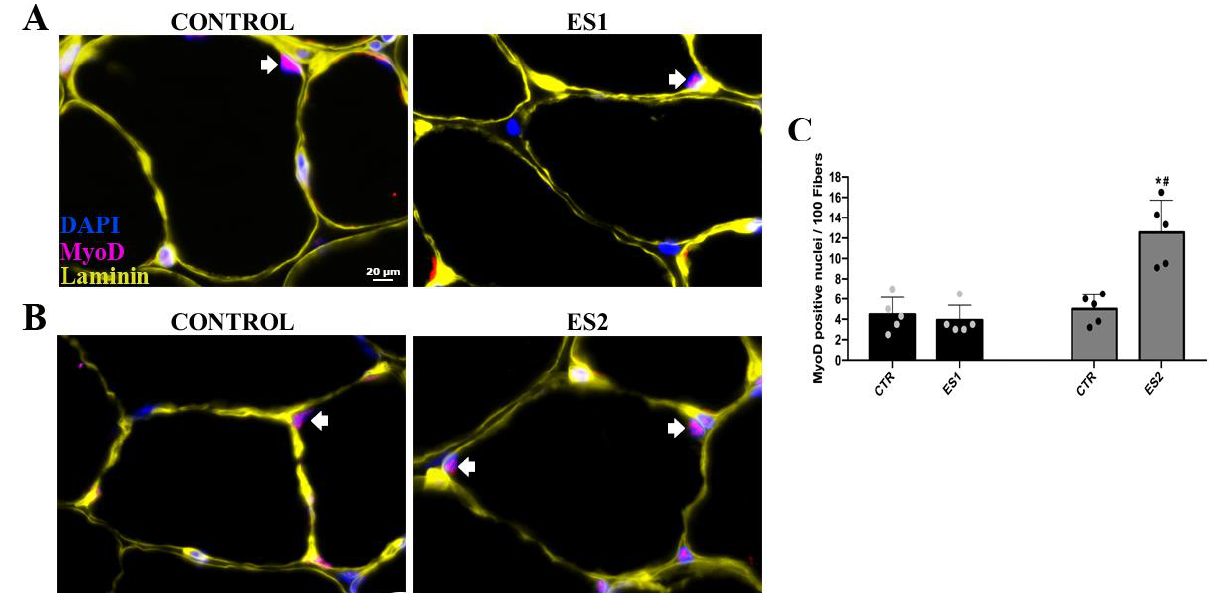
Figure 5. Analysis of MyoD positive cell counts after one and two weeks of electrical stimulation. ( A , B ) Representative immunofluorescence micrographs of DAPI (blue, used to identify nuclei), MyoD (violet), and Laminin (yellow) after one and two weeks, respectively, of electrical stimulation (20 µm scale bar). ( C ) The number of positive MyoD nuclei per 100 fibers after one and two weeks, respectively, of electrical stimulation (n = 5 per group). The arrows indicate MyoD positive cell. The data are presented as mean ± SD. Two-way ANOVA was followed by Tukey ’ s post-test in the statistical analysis. * p < 0.05 in comparison to the relevant control group throughout time and # p < 0.05 vs. one week of training.